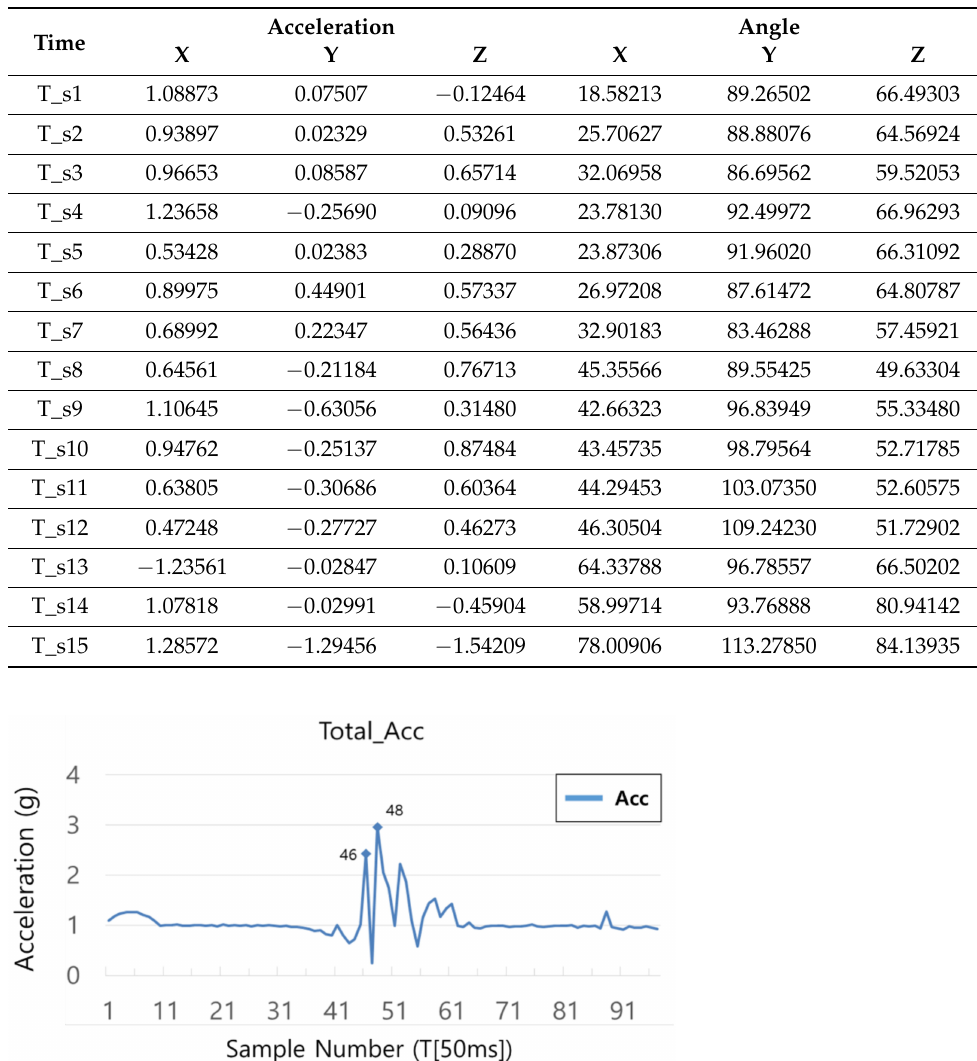
Table 1. Input data of the LSTM model used in this study.